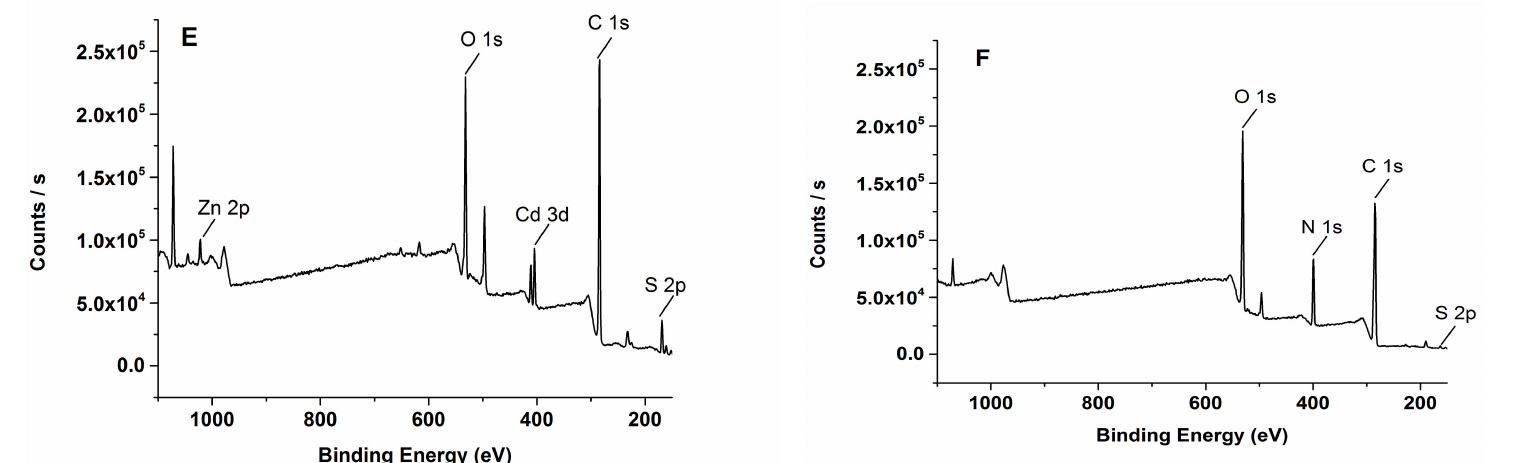
Figure 2. Characterization of QB and QB-pAbs. ( A ) TEM picture of QB. ( B ) Size distribution of QB obtained by TEM. ( C ) Size distribution of QB (solid line) and QB-pAbs probes (dash line) obtained by DLS. ( D ) Fluorescent emission spectra of QB (solid line) and QB-pAbs probes (dash line). ( E ) XPS spectra of QB. ( F ) XPS spectra of QB-pAbs probes.